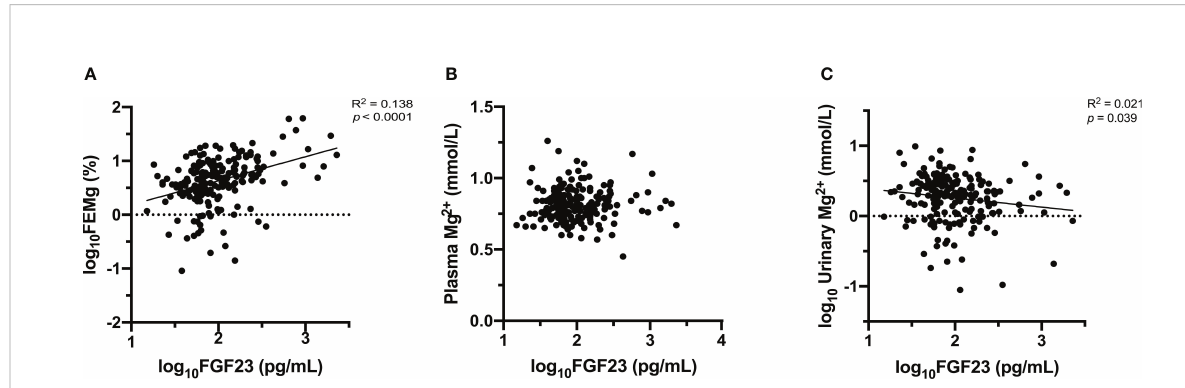
FIGURE 1 Association between FGF23 and Mg 2+ [FEMg (A) , plasma Mg 2+ (B) , urinary Mg 2+ (C) ]. Data are the outcomes of simple linear regression